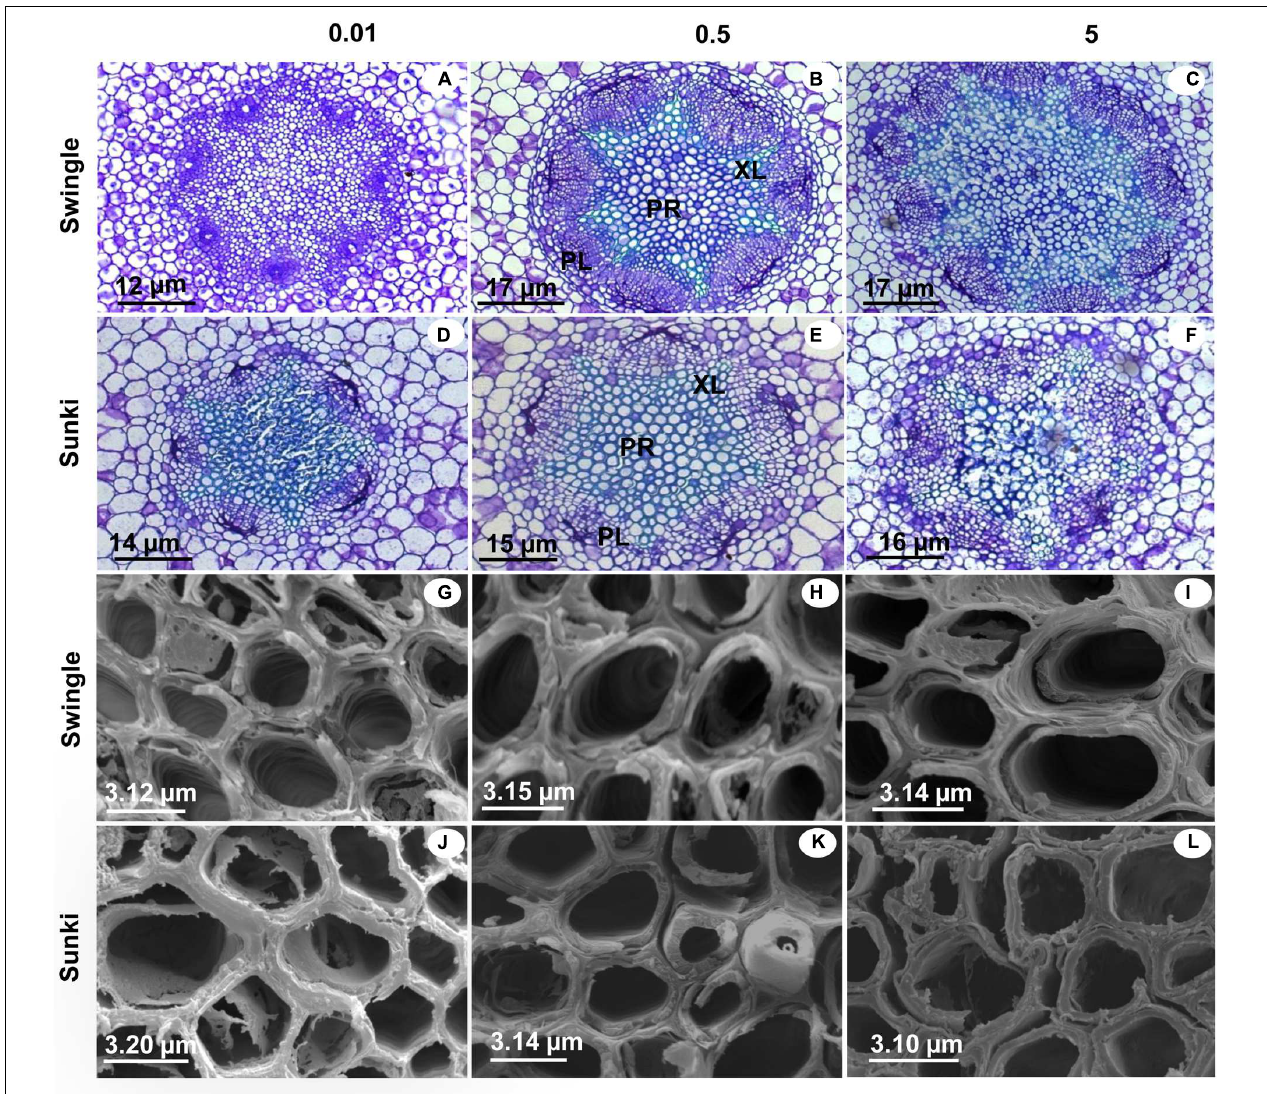
FIGURE 7 | Cross sections of roots under light microscopy (LM) and scanning electron microscopy (SEM) of sweet orange trees grafted on Swingle (LM: A–C; SEM: G–I) or Sunki (LM: D–F; SEM: J–L) rootstocks grown in nutrient solution with varying concentrations of B for 130 days. Concentration of nutrient solution, in mg L − 1 of boron: left (0.01), center (0.5), and right (5.0) columns. Legend: PR, parenchyma; XL, xylem; PL,